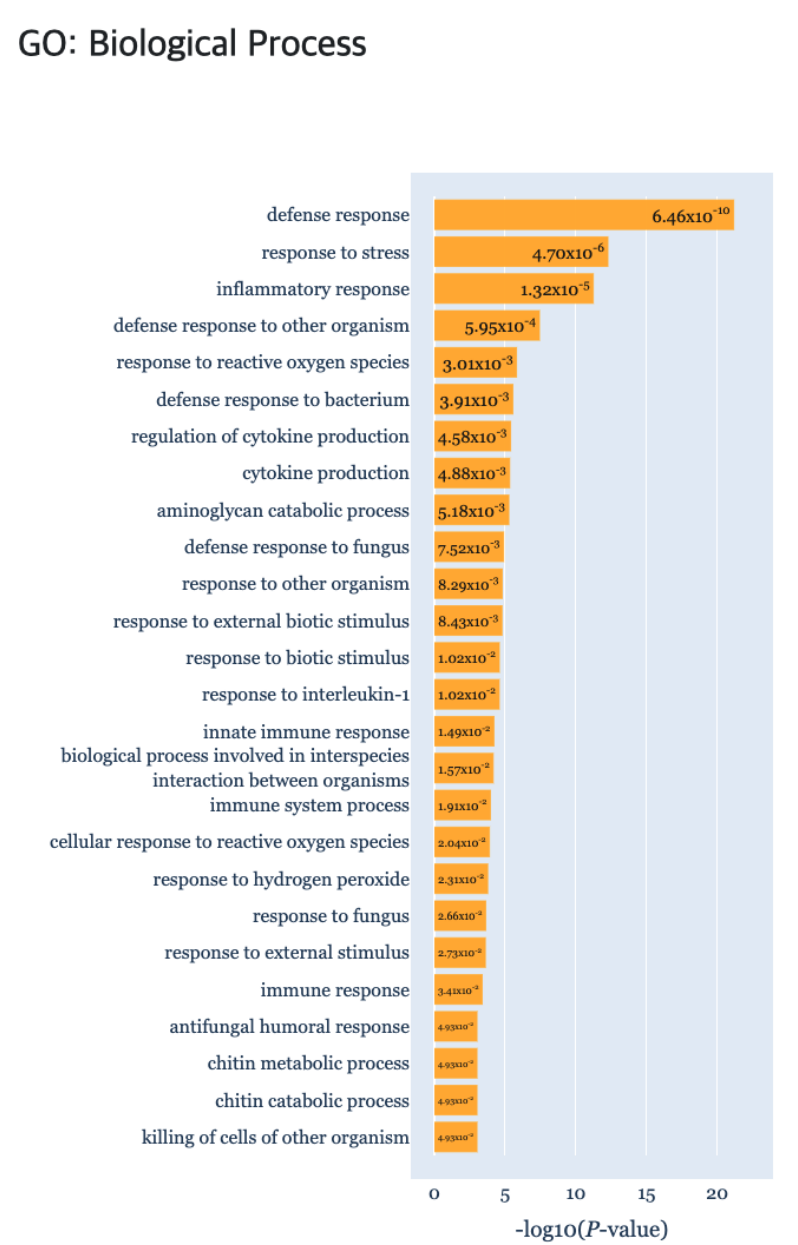
Figure 9. The gene set enrichment analysis results for Case study2 detecting significant GO: Biological Process using